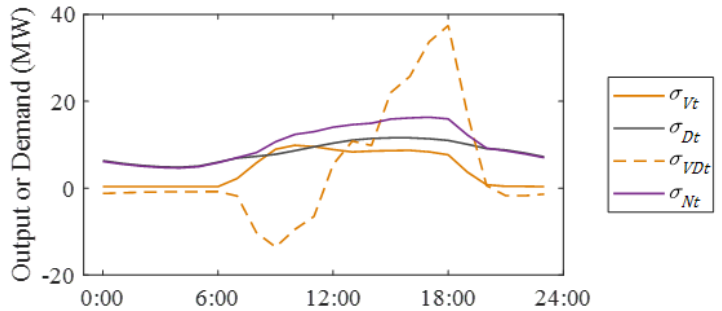
Figure 3. Statistical parameters of PV output and demand.